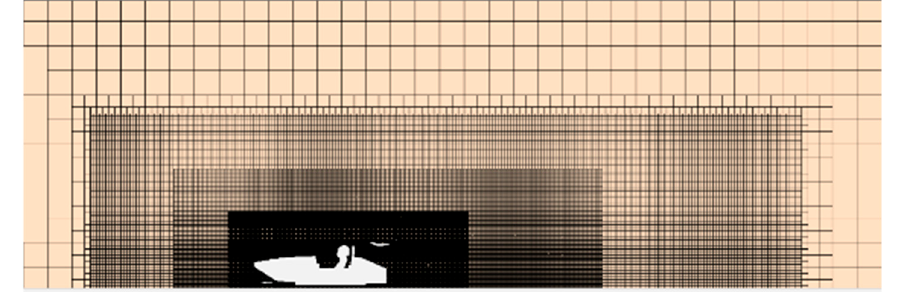
Figure 3. Volume mesh encryption domain.